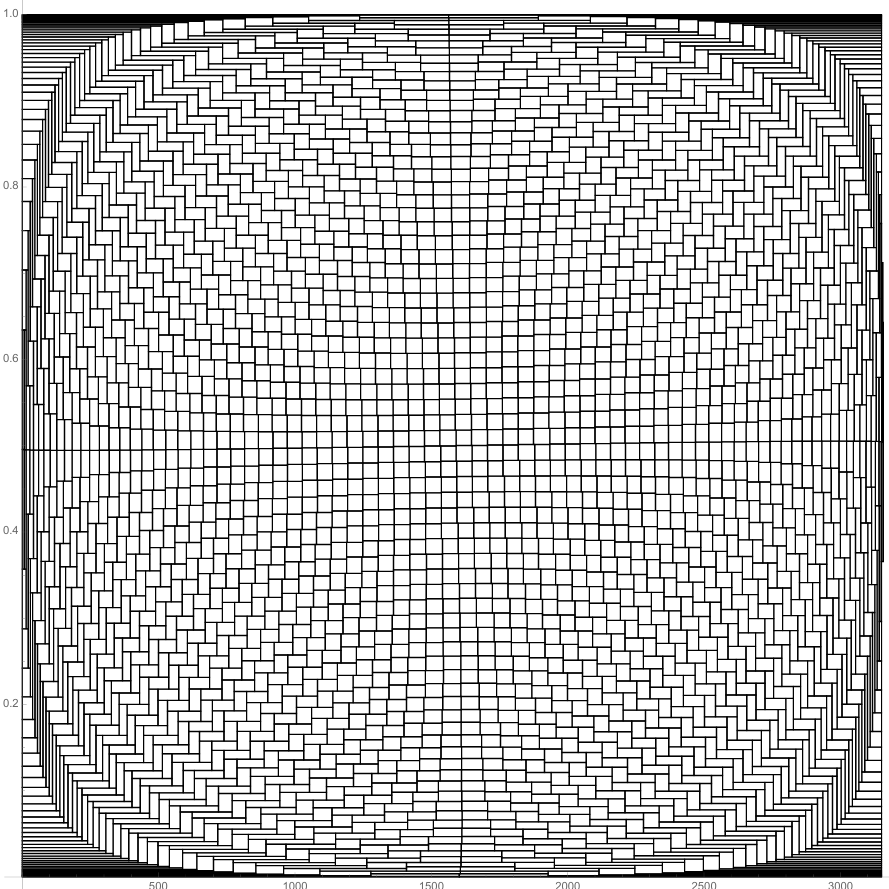
Z 2 , with edges oriented south and west, Figure 5: Smith diagram for the 40 40 square grid [ 0 , 40 ] 2 × ∩ with all energies 1 and boundary values u ( 0 , 0 ) = 0 , u ( 40 , 40 ) = 1. This picture illustrates Theorem 11 n grid, below: the y -coordinates of the tops and bottoms of the rectangles, which are indexed by an n × converge to an analytic function on the square satisfying the enharmonic Laplace equation (11).